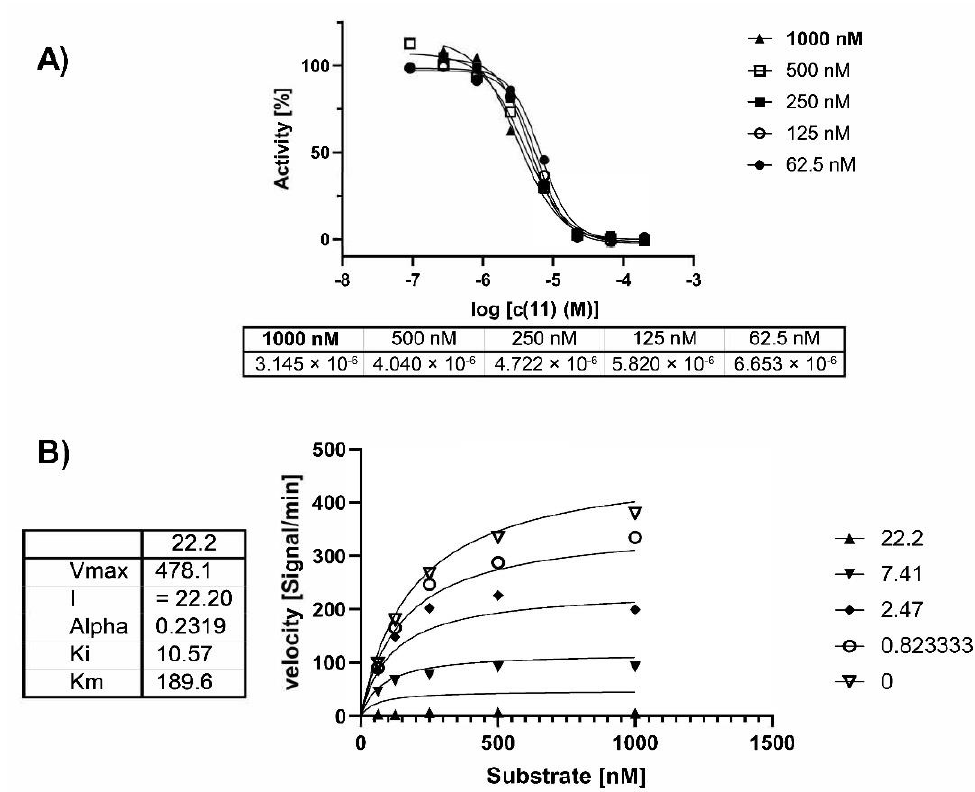
Figure 4. ( A ) Mode of inhibition study: IC 50 curves for compound 11 (ZHAWOC8697) against SENP1 at different substrate (SUMO1-AMC) concentrations; ( B ) global fit of Michaelis-Menten plots (GraphPad Prism).